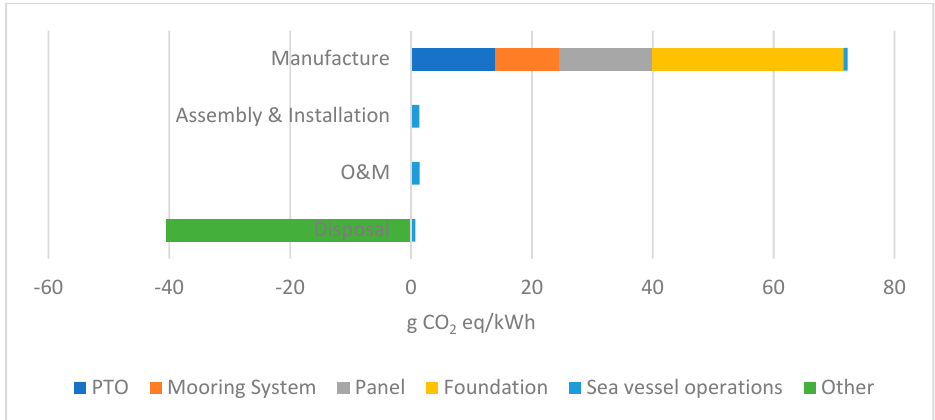
Figure 7. Global Warming Potential (GWP).